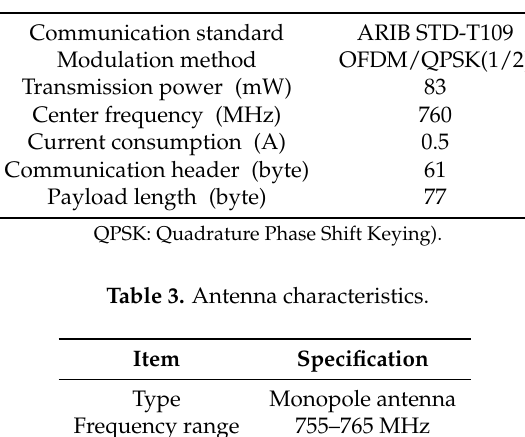
Table 2. Specifications of on-vehicle devices.